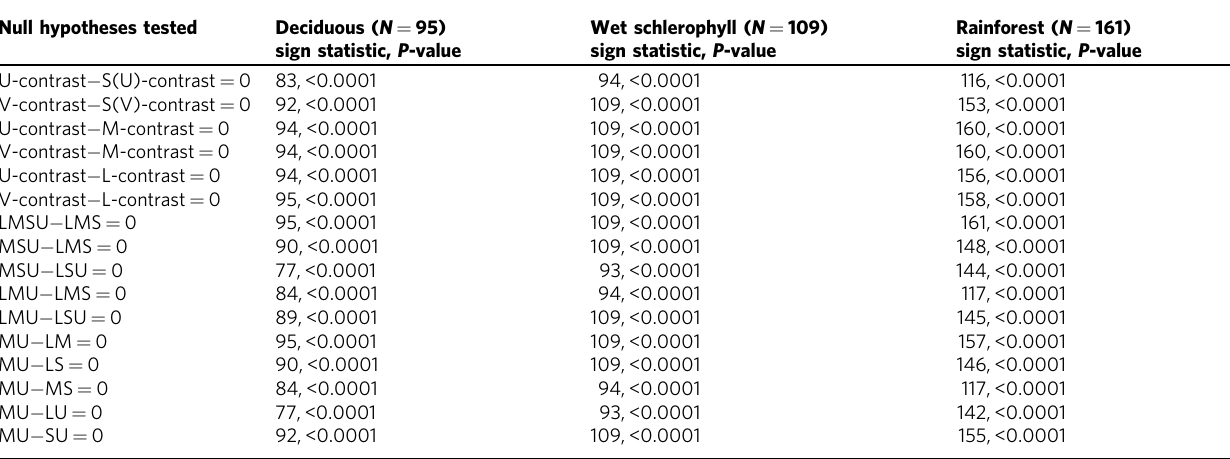
Table 1 Details of sign tests used to analyze data in Fig. 5